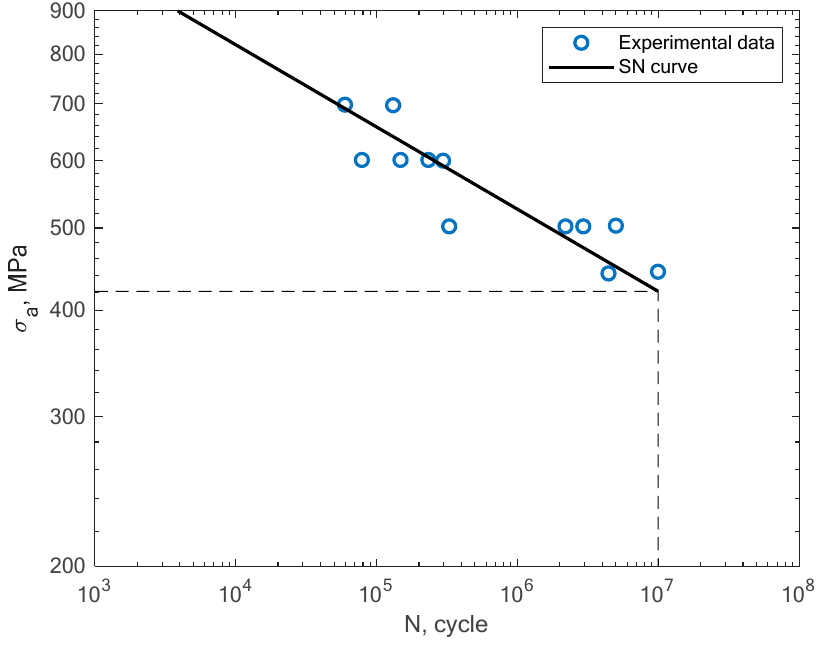
Figure 16. S–N curve for the experimental tension–compression (R = − 1) fatigue test results reported by Damon et al. [17] under the conditions of room temperature and a vertical direction of the printing orientation.